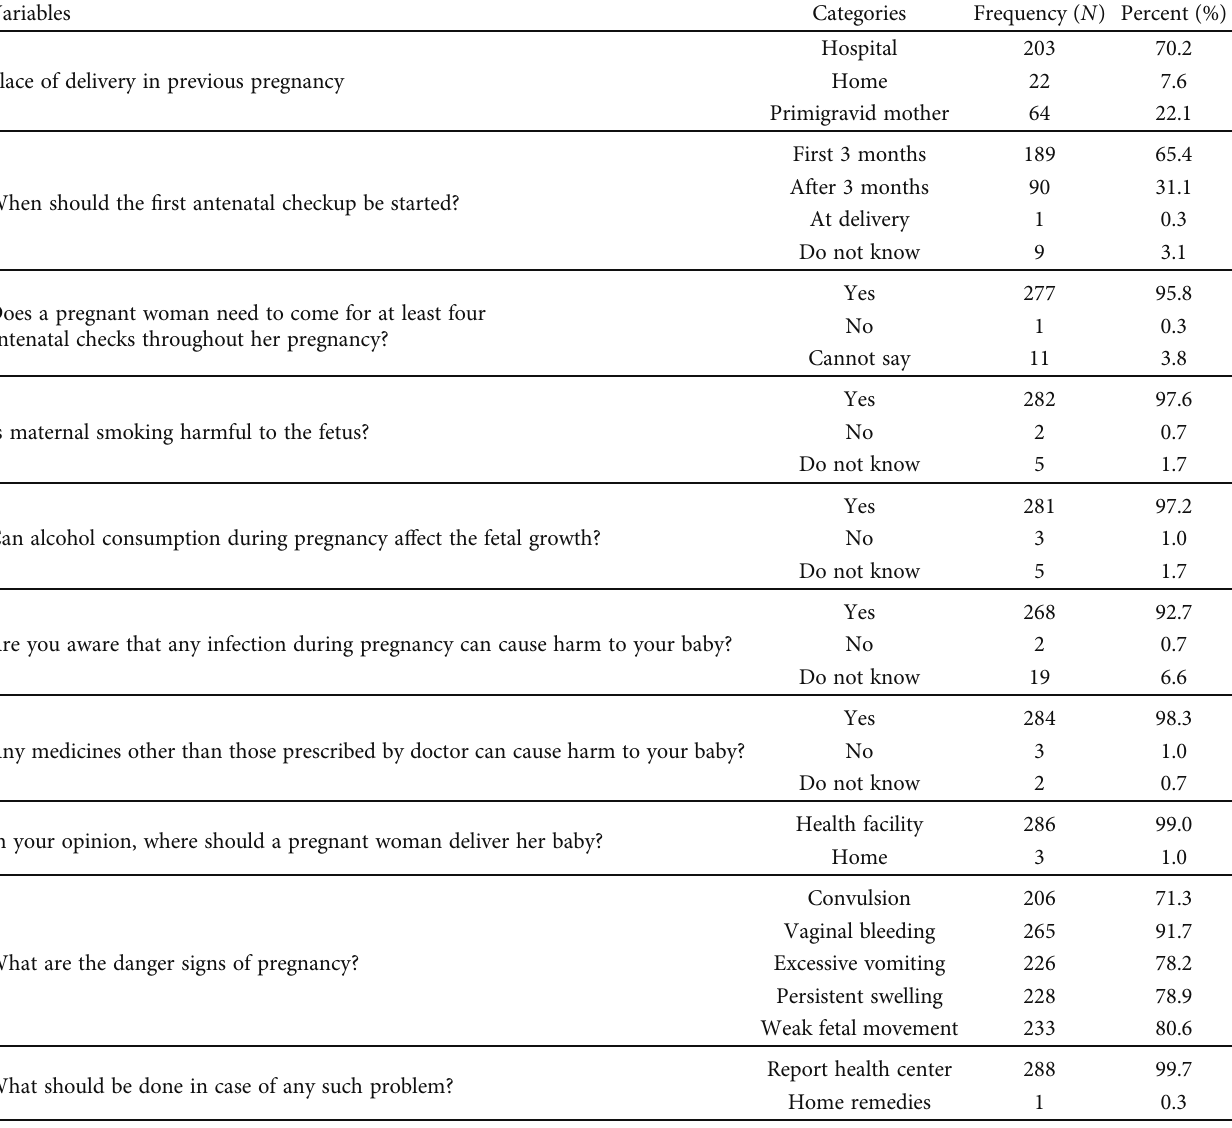
Table 2: Knowledge of pregnant women on antenatal care in Amatere Health Center, Massawa,